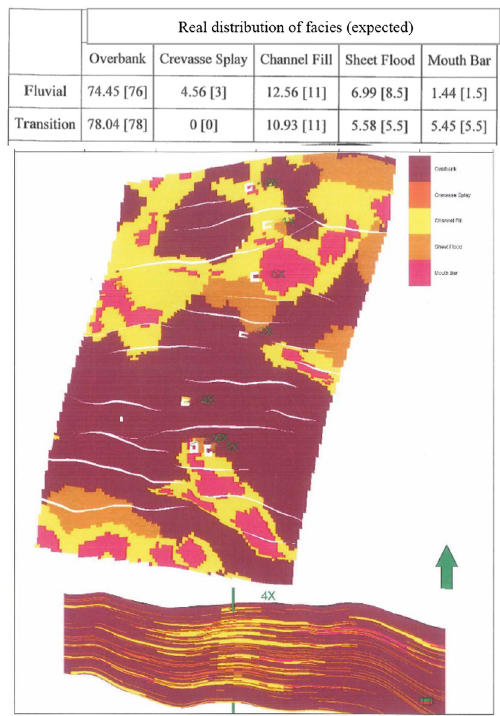
Fig. 30 Resulting model of case R3_1